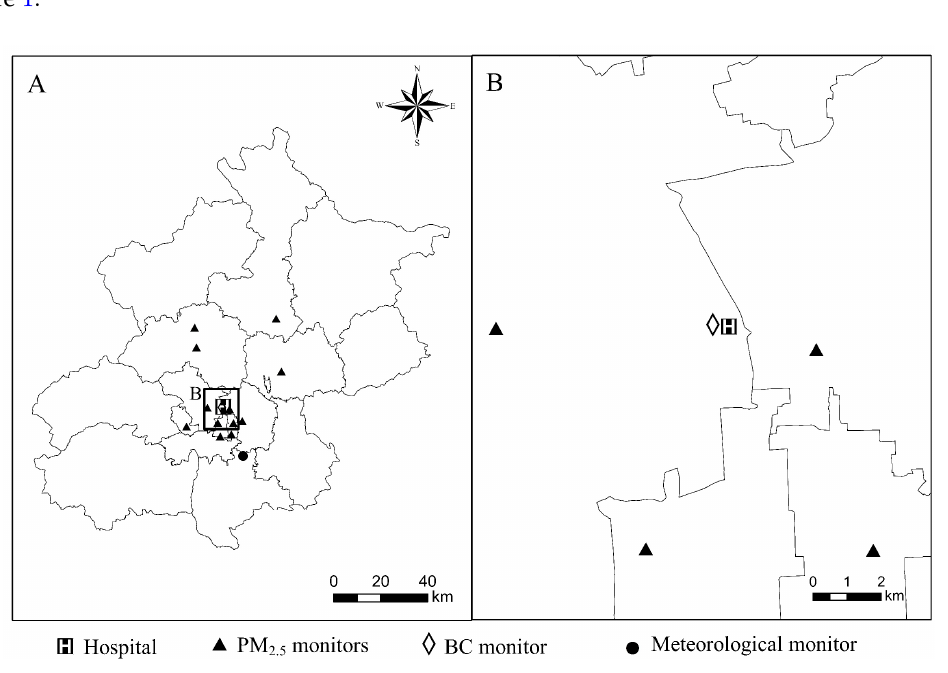
Figure 1. Spatial locations of target hospital and ground PM 2.5 , BC (black carbon), meteorological monitors in this study. The entire region of study is shown in panel A and the area nearest the hospital is shown in panel B